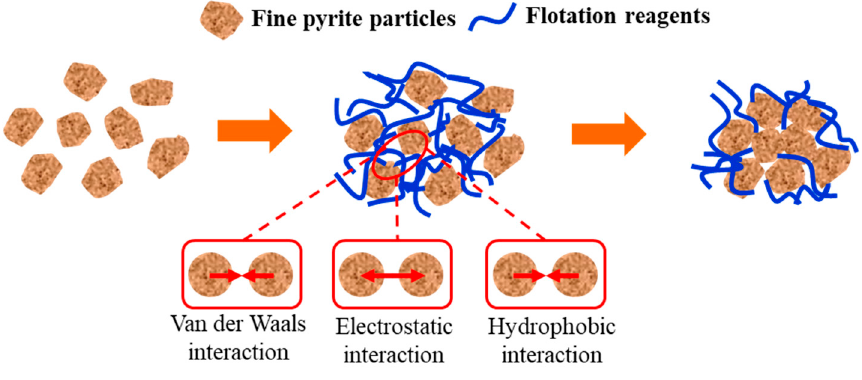
Figure 13. Schematic diagram of hydrophobic agglomeration of fine pyrite particles induced by flotation reagents. flotation